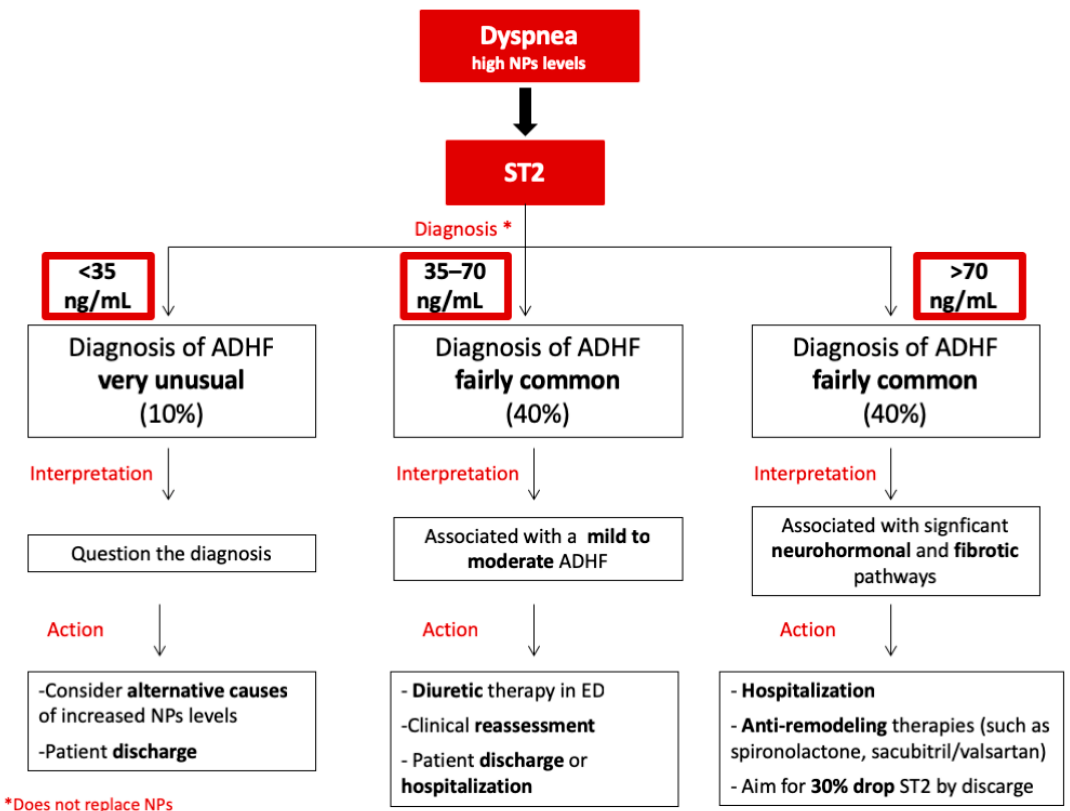
Figure 1. Flowchart showing the proposed soluble ST2 (sST2) aided management of patients with dyspnea and elevated natriuretic peptides (NPs). In patients with dyspnea and elevated NPs, sST2 levels can help to identify 3 classes of patients. If sST2 < 35 ng/mL, the diagnosis of acute decompensated heart failure (ADHF) is unusual. In patients with 35 ≤ sST2 ≤ 70 ng/mL, ADHF is more common but mild to moderate. If sST2 > 70 ng/mL, ADHF is fairly common, requiring hospitalization and anti-remodeling therapies. Suggested actions for each class of patients are shown in the panels below.